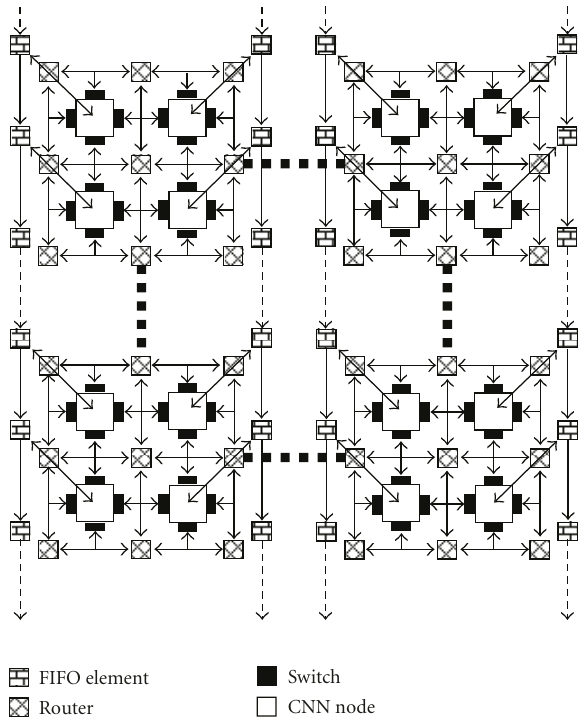
Figure 3: Caballero architecture uses a network-on-chip of CNN nodes, while the pixels are transported over a distributed FIFO.